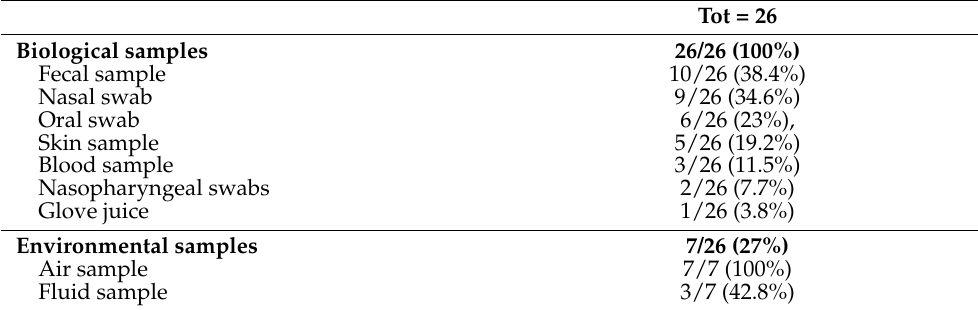
Table 3. Tools for microbiota samplings.